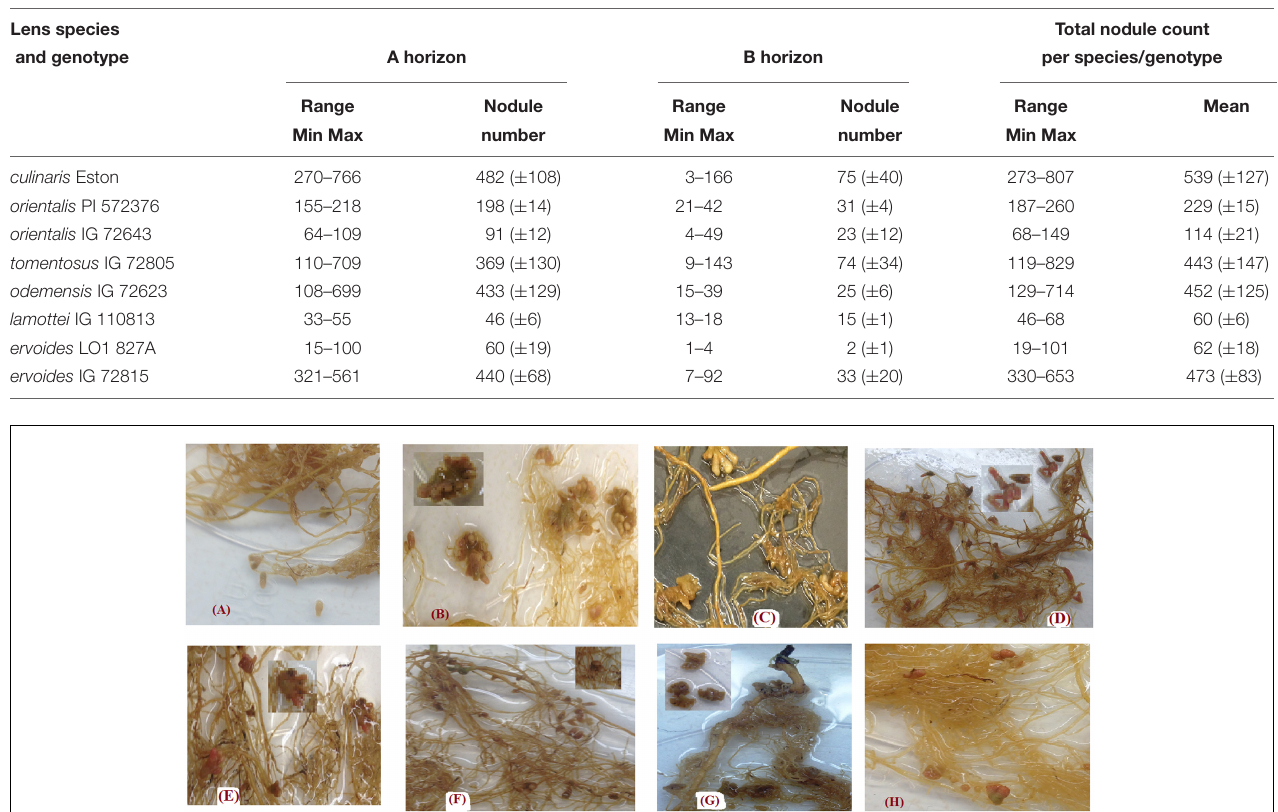
TABLE 2 | Range and mean of nodule number in the A and B soil horizons for five wild lentil species compared with Lens culinaris Eston (Mean ± SE). Lens species